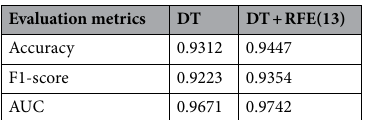
Table 4. Results of DT with the selected features.